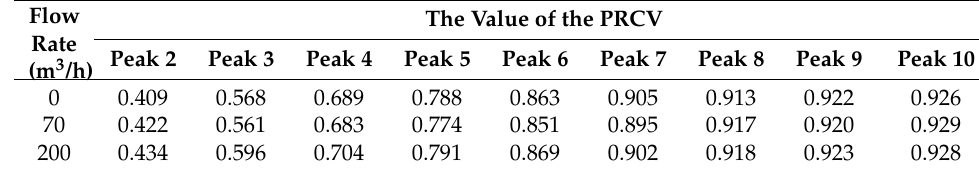
Figure 6. The value of the PRCV at different flow rates in the gas ultrasonic signal. Table 1. Numerical comparison of the value of the PRCV under different flow